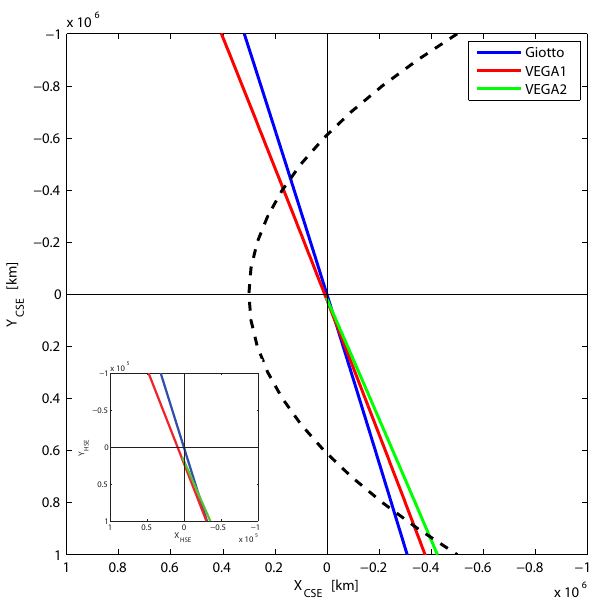
Figure 1. The orbits of the three close flybys by Giotto (blue), Fig. 1. The orbits of the three close flybys by Giotto (blue), VEGA 1 (red) and VEGA 2 (green) in CSE coordinates. The dashed line shows the location of the bow shock for the Giotto flyby as a guidance. Note VEGA 1 (red) and VEGA 2 (green) in cometocentric–solar–ecliptic thatthebowshocklocationwilldifferfortheothertwoflybys. Theinsetpanelshowsazoom-intoclarifythe (CSE) coordinates. The dashed line shows the location of the bow differenceintheorbitsnearthecomet. shock for the Giotto flyby as a guidance. Note that the bow shock location will differ for the other two flybys. The inset panel shows a zoom-in to clarify the difference in the orbits near the comet.